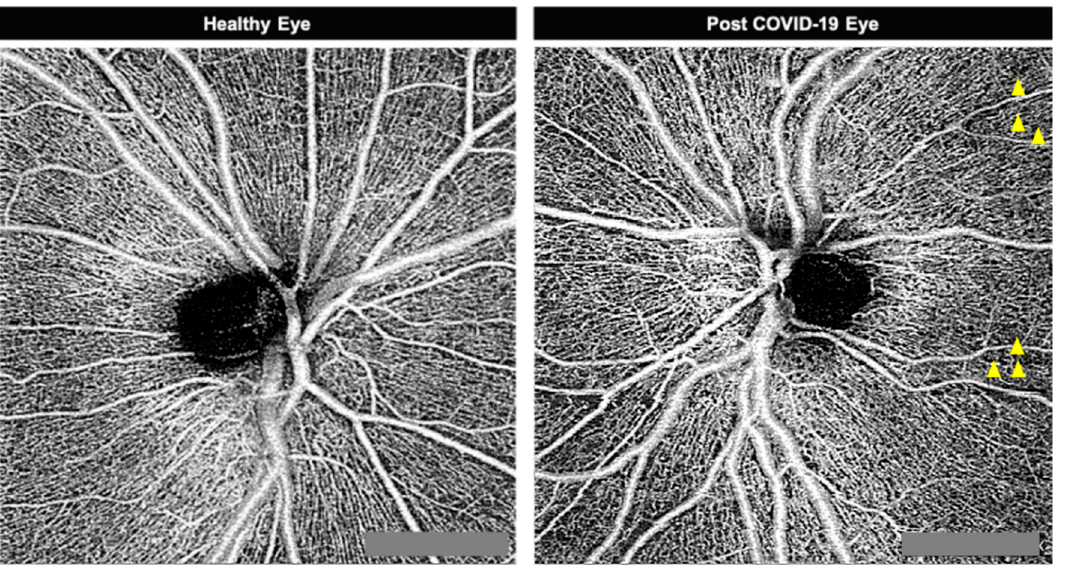
Figure 1. Optical Coherence tomographic angiography (4.5 × 4.5 mm) centered into the disc in healthy and post COVID-19 patient’s eyes. The yellow arrowhead shows the perfusion defect.